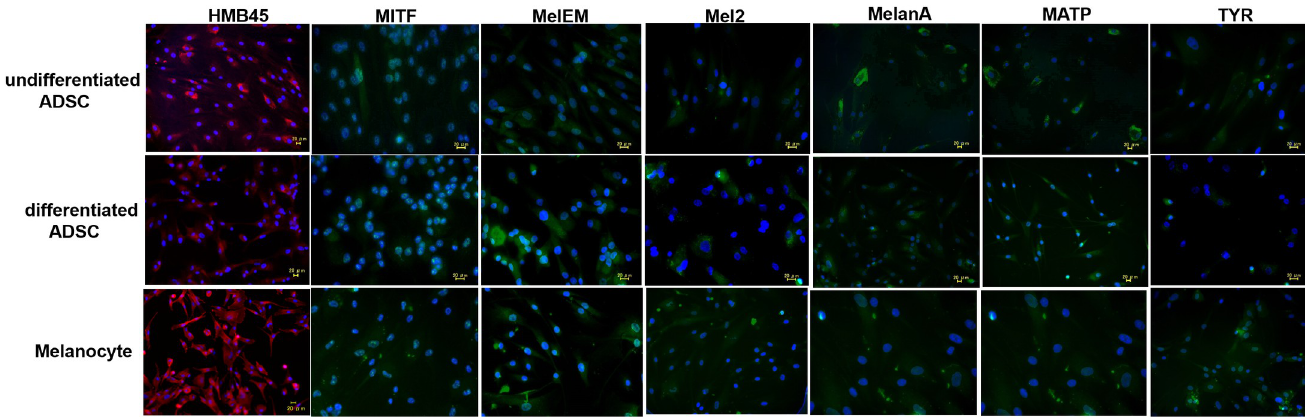
Fig 1. The expression of melanocytic markers in undifferentiated and differentiated ADSCs detected by immunofluorescence microscopy. The expression levels of HMB45, MITF, MelEM, Mel2, MelanA, MATP, and tyrosinase (TYR) in undifferentiated and differentiated ADSCs, as well as NHEMs, were examined by immunofluorescence microscopy. All melanocytic markers except for TYR were detected.